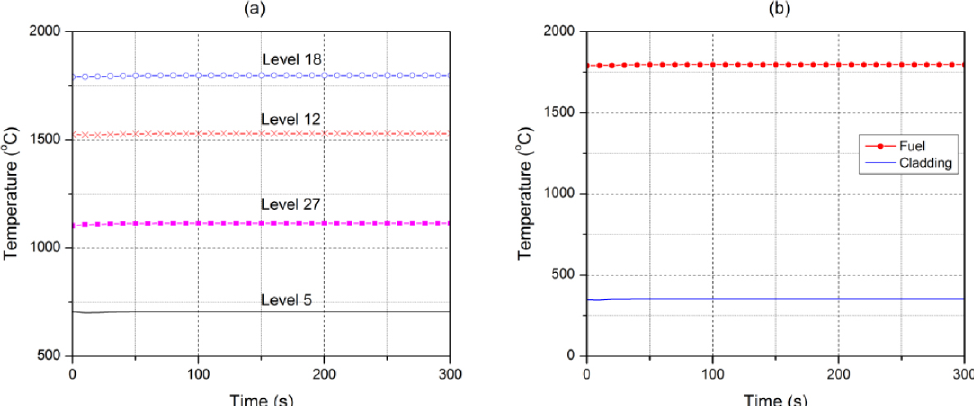
Fig. 3. Time evolution of fuel temperature at different axial positions in HS-6050 (a). Fuel and cladding temperature at level 18 (b).